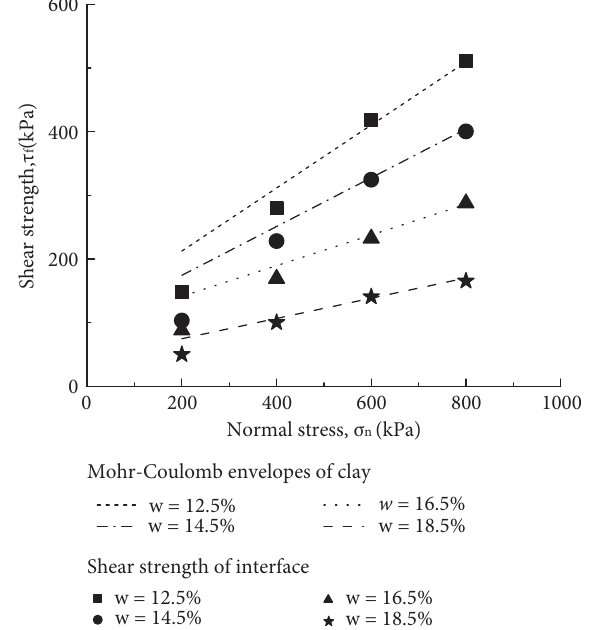
Figure 7: Shear strength of interface and